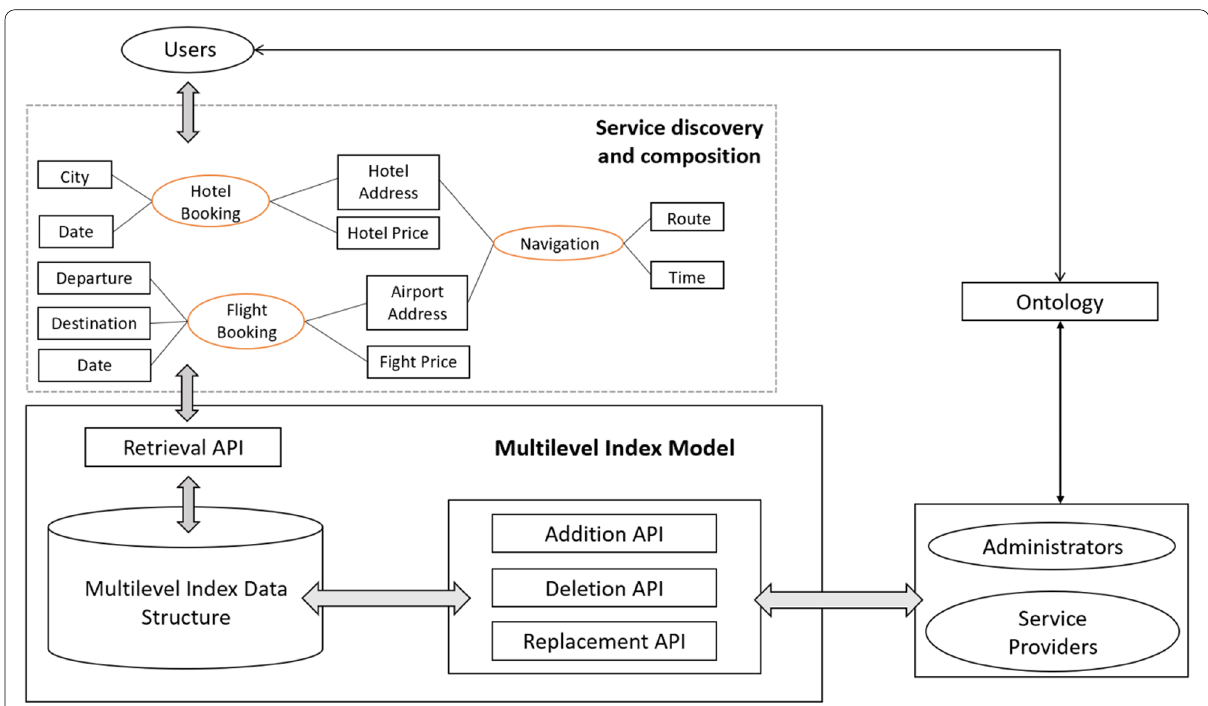
Fig. 1 An application scenario for the service multilevel index